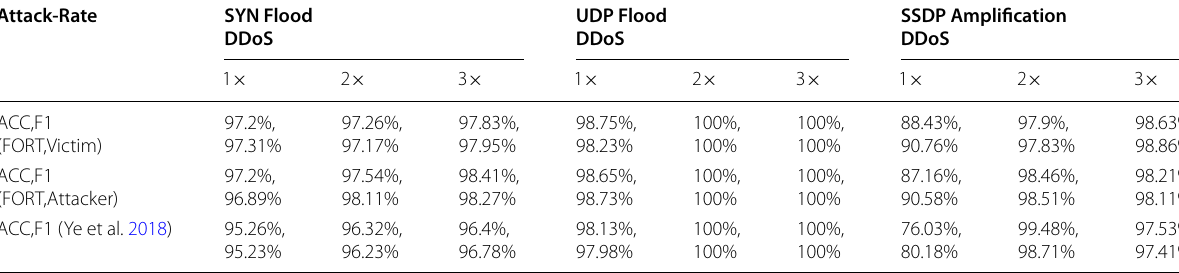
Table 3 Performance with different attack rates